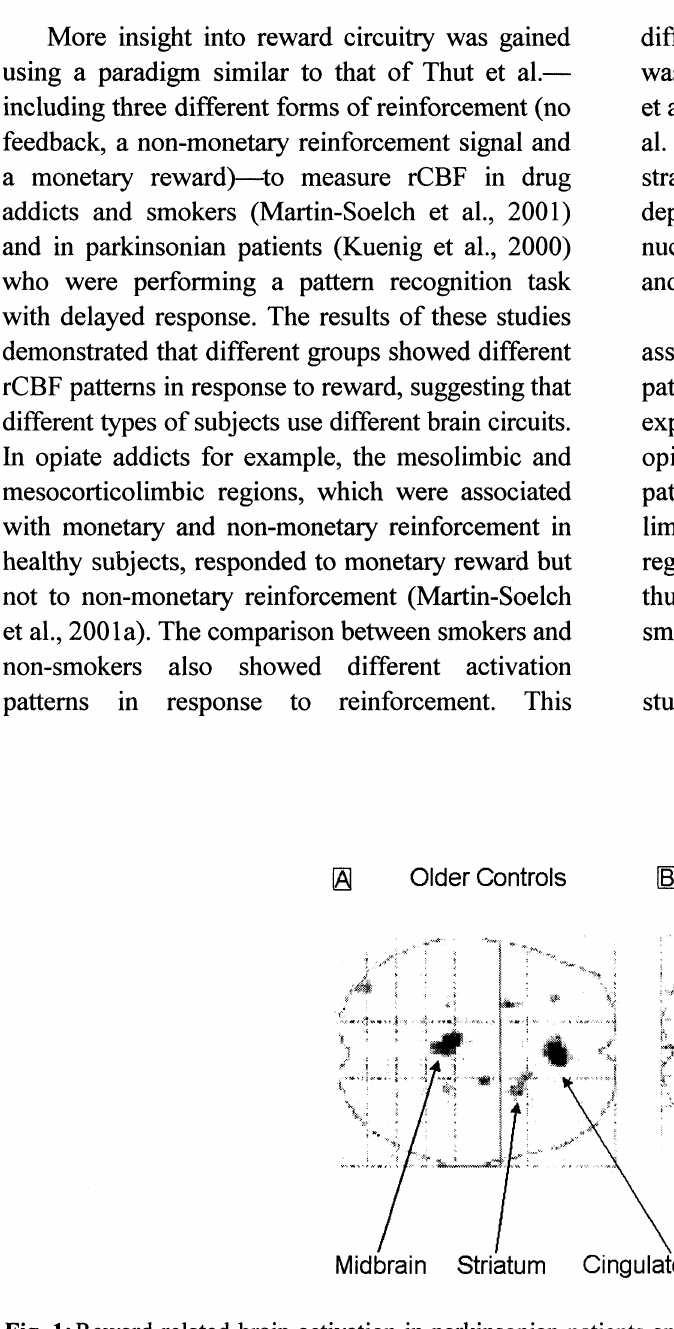
Fig. l:Reward-related brain activation in parkinsonian patients and in age-matched controls. A coronal projection of a glass brain of significantly activated brain areas when subjects are monetary rewarded. Regions activated in older controls" bilaterally in the striatum, caudate nucleus and anterior cingulate gyrus, and unilaterally in the left cerebellum, midbrain and medial frontal gyrus (adapted from Kuenig et al., 2000). Regions activated in parkinsonian patients: right medial frontal cortex, left superior parietal lobule, medial temporal gyrus, thalamus and right and left cerebellum. (adapted from Kuenig et al.,